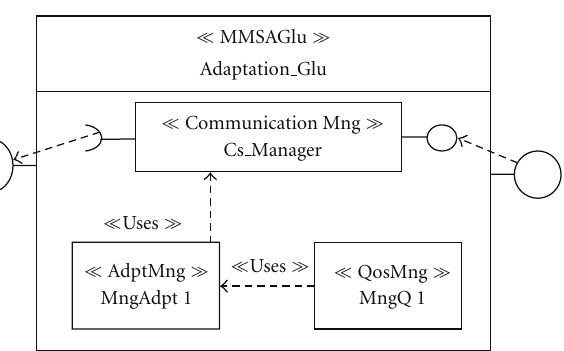
Figure 4: MMSA component.